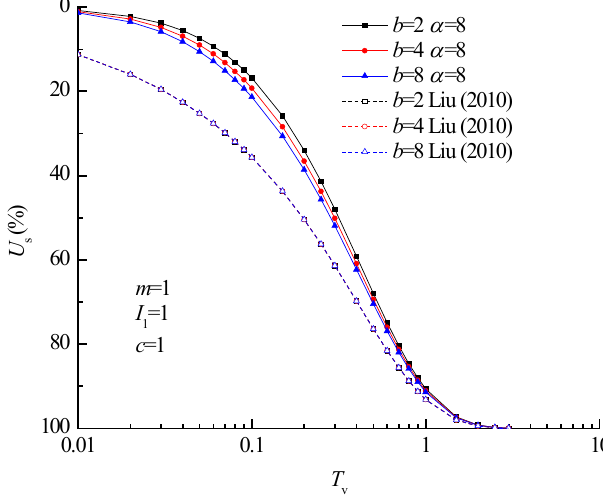
Figure 9. Influence of the b value on ACDS ( m = 1, c = 1) [23].